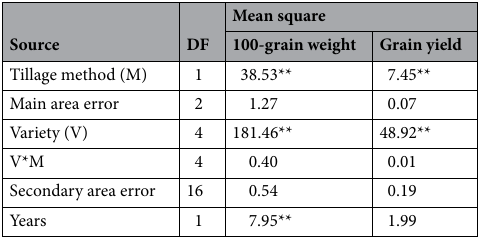
Table 2. Variance analysis of the effect of tillage method and variety on the 100-grain weight and grain yield of maize. **Significant at P ,